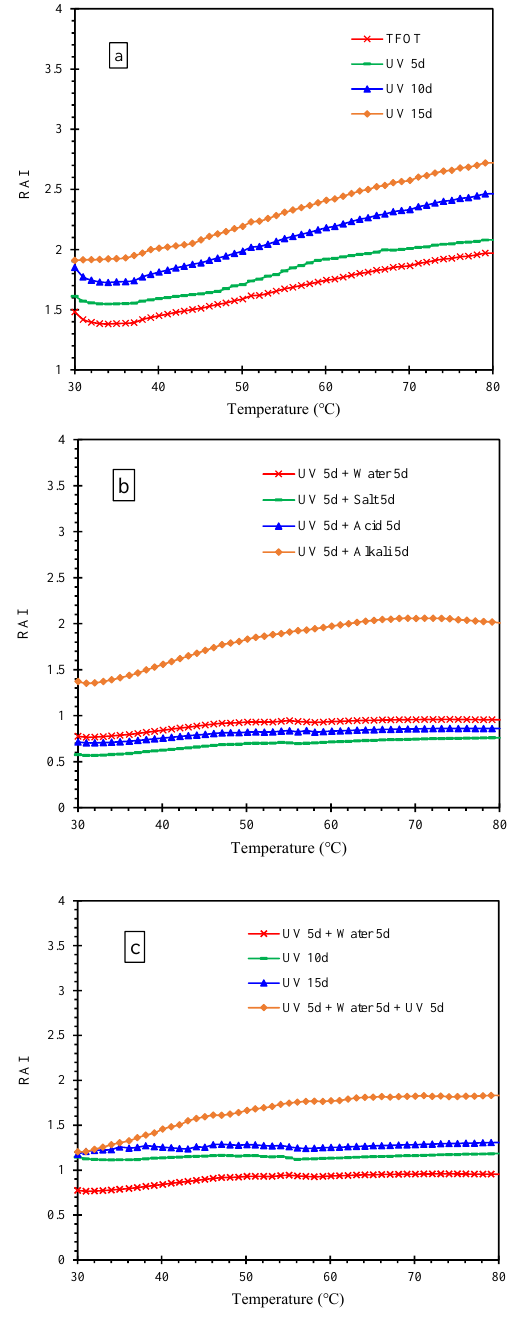
Figure 4. RAI of asphalt after the multiple aging of heat, UV and solution. ( a ) multiple aging of heat and UV; ( b ) multiple aging of heat, UV and solution; ( c ) aging cycle of UV and water.